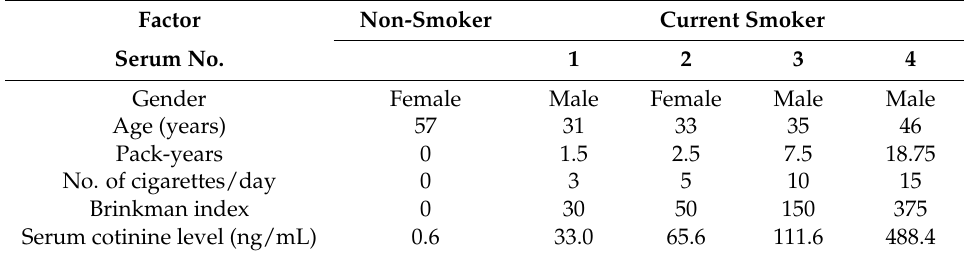
Table 1. Characteristics and smoking status of four smokers and a non-smoker. Factor